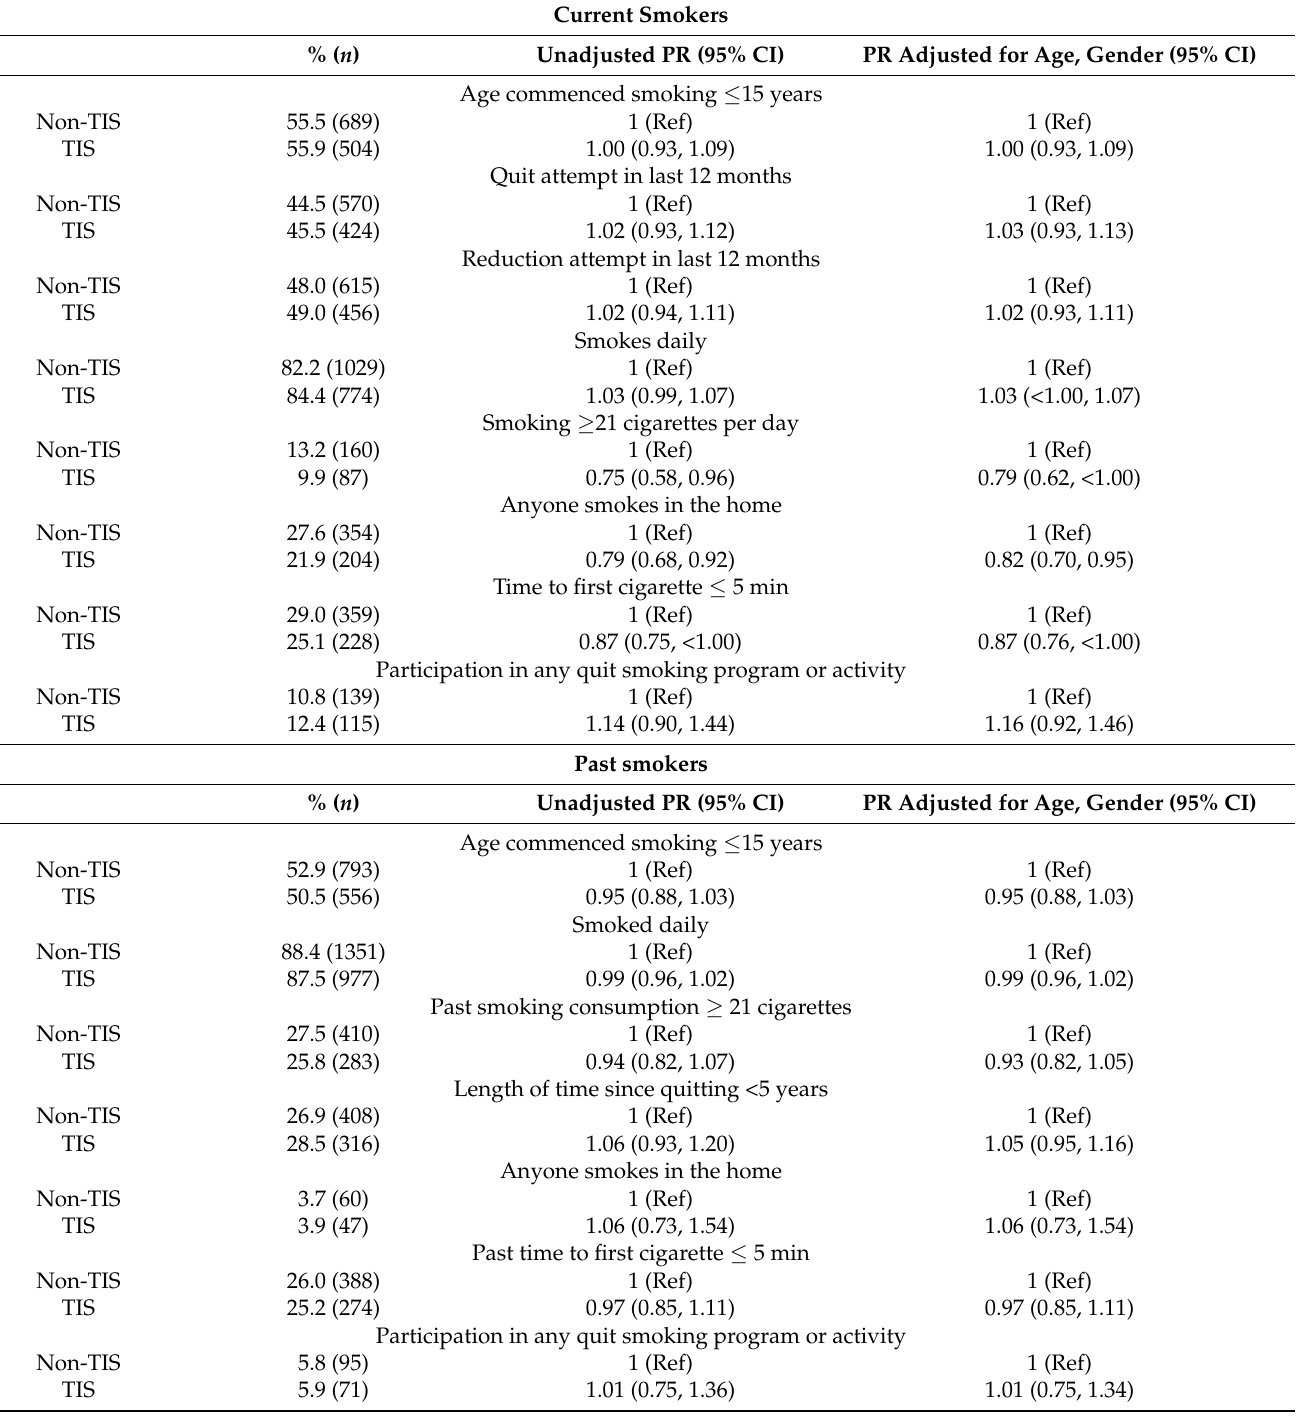
Table 7. Relationships between TIS and smoking-related behaviours, among current smokers and among past